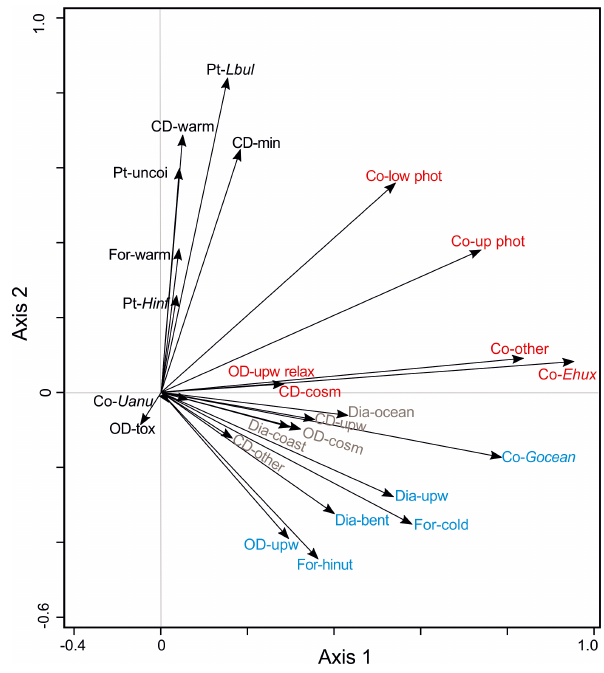
Figure 6. Results of a PCA analysis of ecological groups of the organism groups at the CBeu trap site between June 2003 and March 2008. References are given as follows. Dia (diatoms); -bent: benthic, -coast: coastal planktonic, -ocean: open ocean, -upw: up- welling; Co (coccolithophores); - Ehux : Emiliania huxleyi , - Gocean : Gephyrocapsa oceanica , -low phot: lower photic zone, -other: other coccolithophorids, - Uanu : Umbilicosphaera anulus , -up phot: up- per photic zone; CD (calcareous dinoflagellate cysts); -cosm: cos- mopolitan group, -min: terrestrial mineral group, -other: species that do not fit in one of the other ecological groups, -upw: up- welling, warm: warm waters; OD (organic-walled dinoflagellate cysts); -cosm: cosmopolitan group, -other: species that do not fit in one of the other ecological groups, -tox: potential toxic group, -upw: upwelling, -upw relax: upwelling relaxation; For (planktonic foraminifera); -cold: cool water group, -hinut: high-nutrient waters group; -warm: warm-water group; and Pt (pteropods); - Hinf : He- liconoides inflatus , - Lbul : Limacina bulimoides , -uncoi: uncoiled. Groups of microorganisms are identified by colors (light blue, group 1; brown, group 2; black, group 3; and red, group 4). The species-specific composition of groups is presented in Table 5. For interpretation of the references to color in this figure legend, the reader is referred to the web version of this